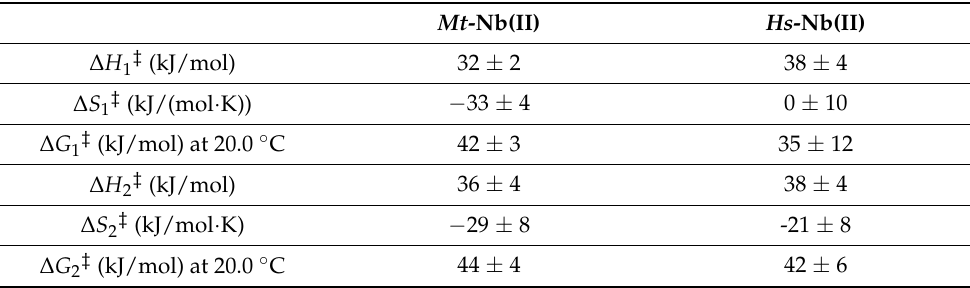
Table 2. Activation enthalpies ( ∆ H ‡ ) and entropies ( ∆ S ‡ )”parameters for bimolecular CO binding rates in Mt -Nb(II) and Hs